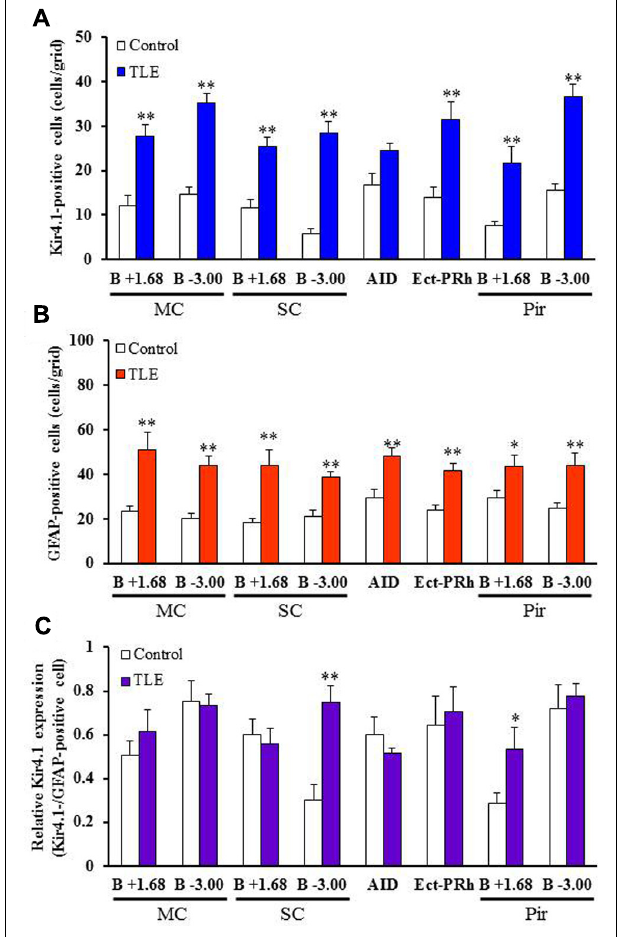
FIGURE 3 |Topographical expression of Kir4.1 and GFAP in the cortical regions of pilocarpine-inducedTLE rats. (A,B) Number of Kir4.1 (A) - or GFAP (B) -immunoreactivity (IR)-positive cells. (C) Relative Kir4.1 expression ratios in astrocytes. A pair of successive slices in each region from the same animal was stained with anti-Kir4.1 or anti-GFAP antibody.The Kir4.1 expression ratios were calculated as the ratios of Kir4.1-positive astrocytes relative to the total number of astrocytes (Kir4.1-positive cells/GFAP-positive cells) in each animal. MC, motor cortex; SC, sensory cortex; AID, agranular insular cortex, dorsal part; Ect-PRh, ectorhinal- perirhinal cortex; Pir, piriform cortex. Each column represents the mean ± S.E.M. of seven animals. * P < 0.05, ** P < 0.01, significantly different from control